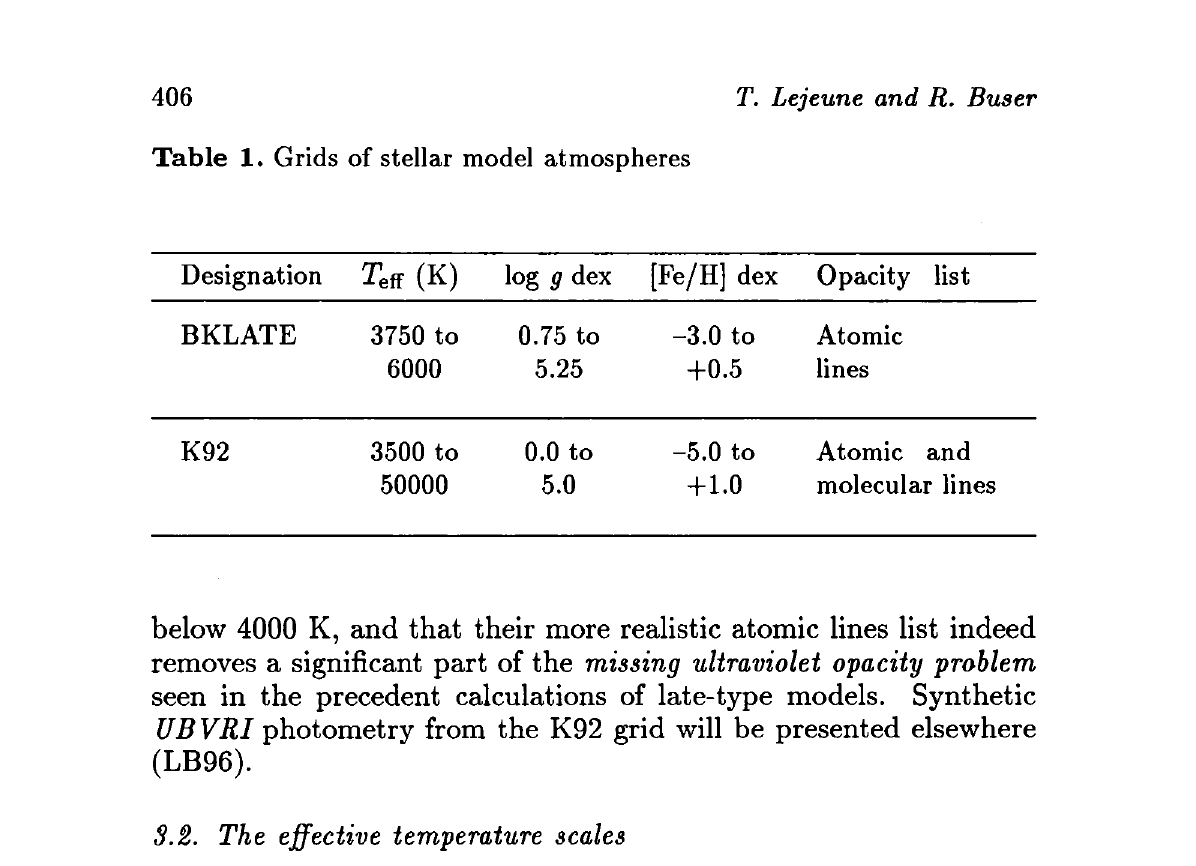
Table 1. Grids of stellar model